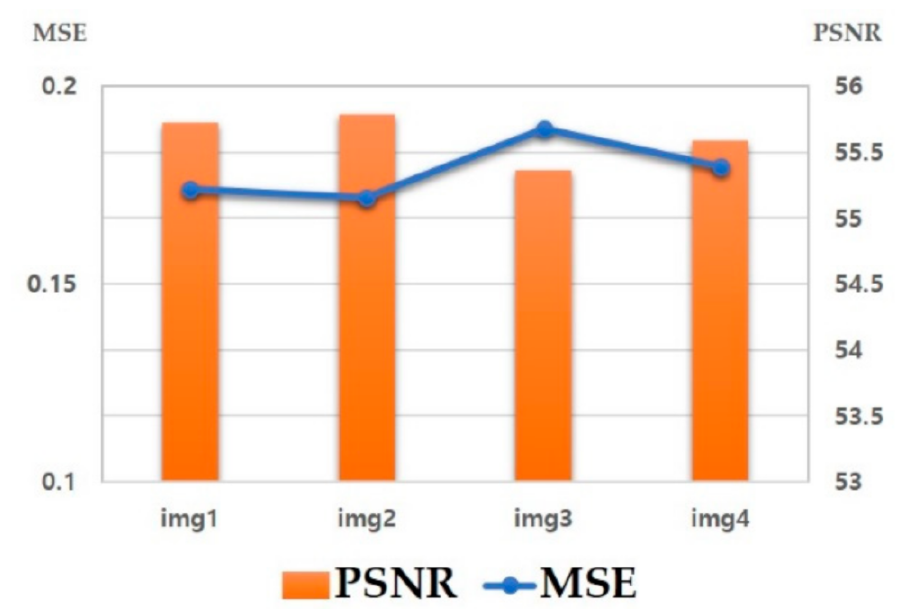
Figure 8. Result of mean square error (MSE), peak signal-to-noise ratio (PSNR) per image.